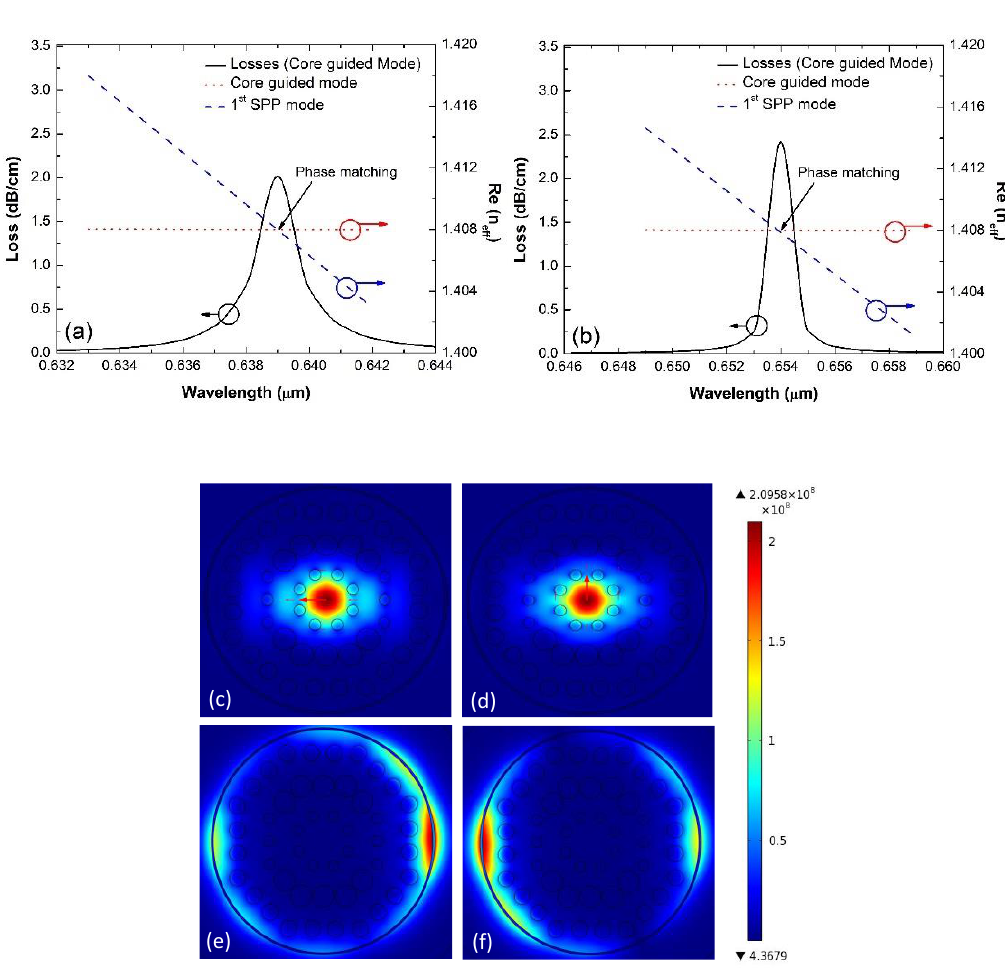
Figure 2. Dispersion relation between the core guided mode and the first SPP mode for: ( a ) x and ( b ) y polarization. Electric field distribution at the phase-matching condition of the ( c ) x and ( d ) y polarization core mode and ( e ) x and ( f ) y polarization SPP mode. These results were obtained for a graphene layer with a thickness of 40.12 nm and an analyte RI of 1.338.